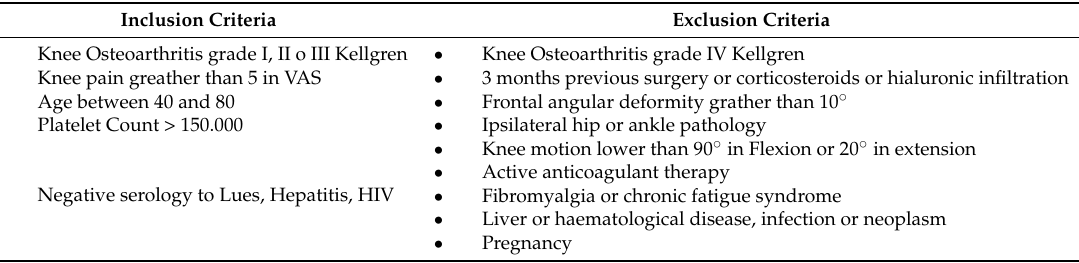
Figure 1. Flow diagram including the number of patients recruited, excluded and randomized at different times during the trial. Table 1. Patient inclusion and exclusion